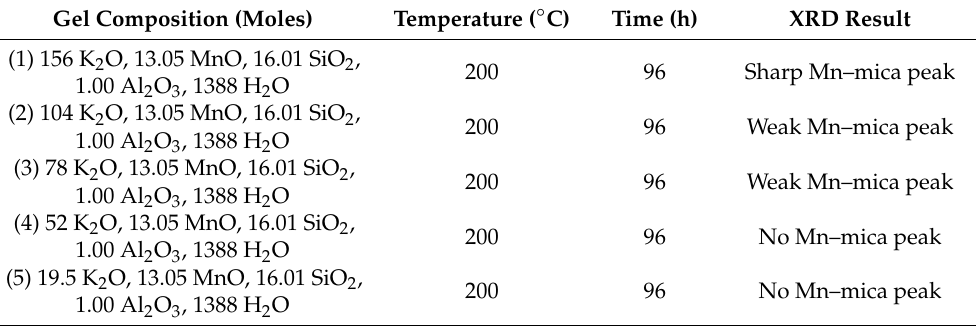
Table 1. Gel composition and X-ray di ff raction (XRD) results for the preparation of Mn–mica at di ff erent KOH